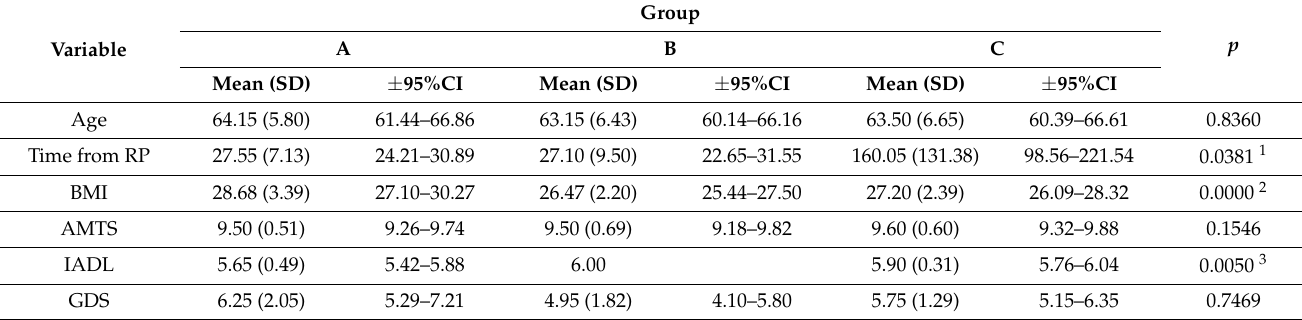
Table 1. Characteristics of the